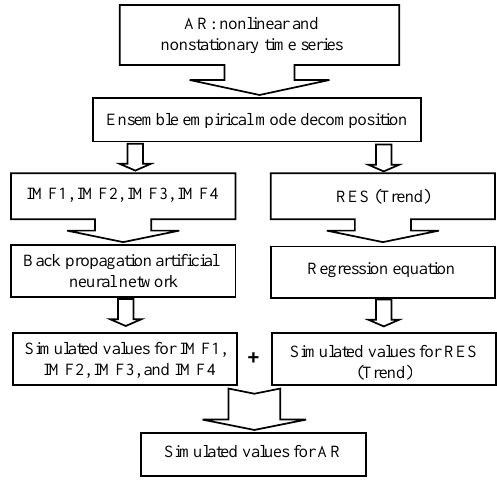
Figure 2. The framework of the hybrid model to simulate